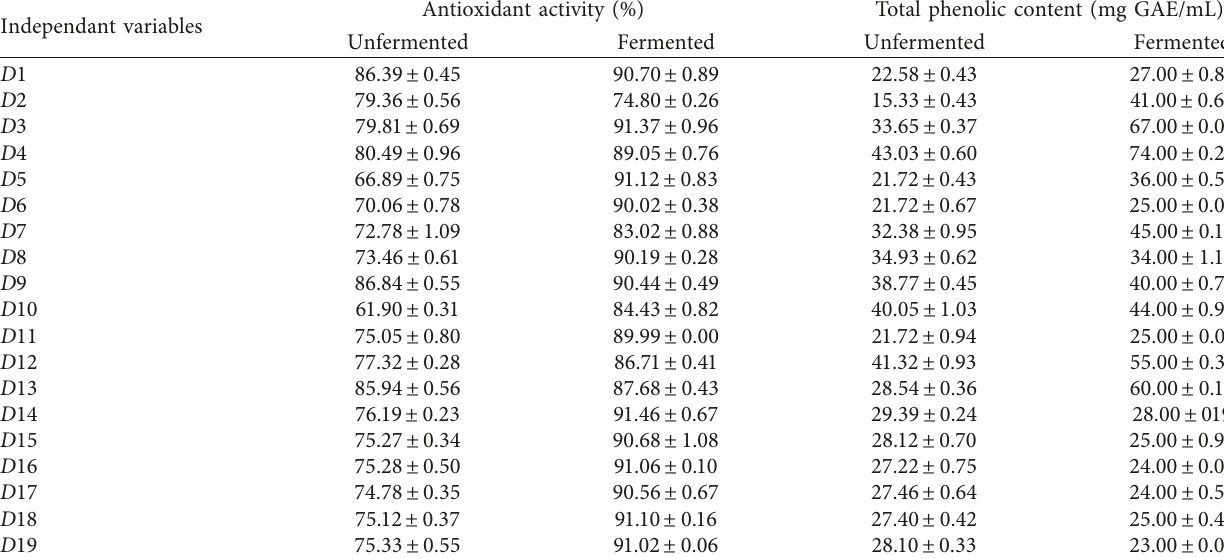
Table 6: Comparison of scavenging activity % and total phenolic content (mg GAE/mL) between fermented beverages and